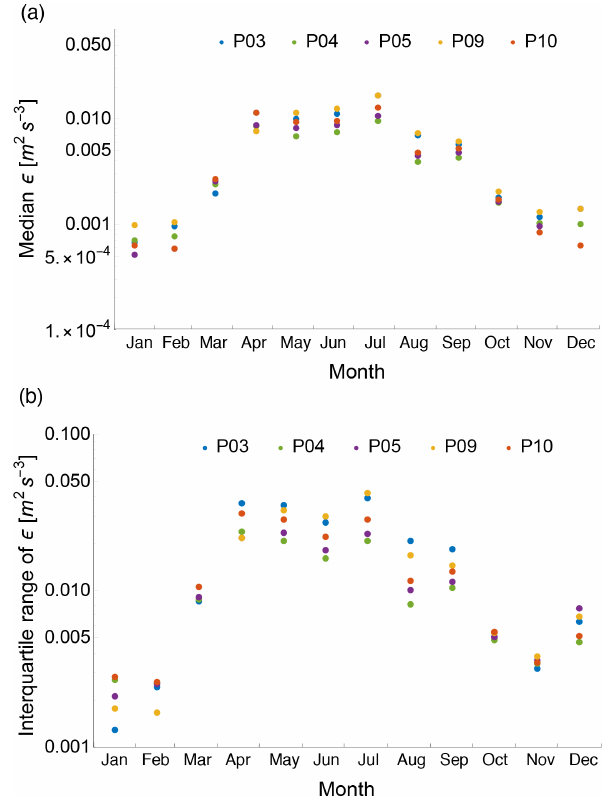
Figure 7. Median (cid:15) value for each calendar month and each con- sidered sonic anemometer (a) and the correspondent interquartile range (b) .